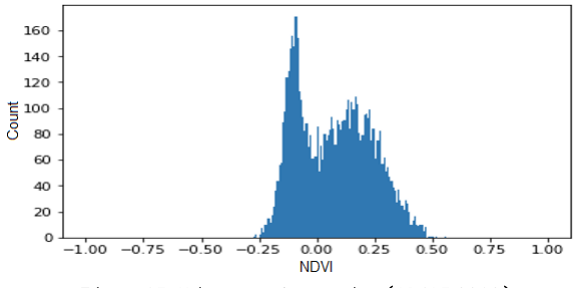
Figure 15. Histogram Generation (NDVI-2010)